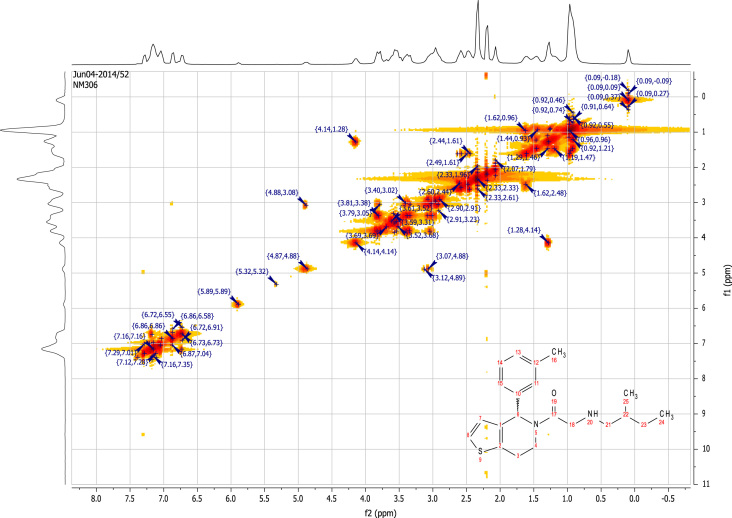
2D COSY (400 MHz,
CDCl3) of RU-SKI 101
(9c).